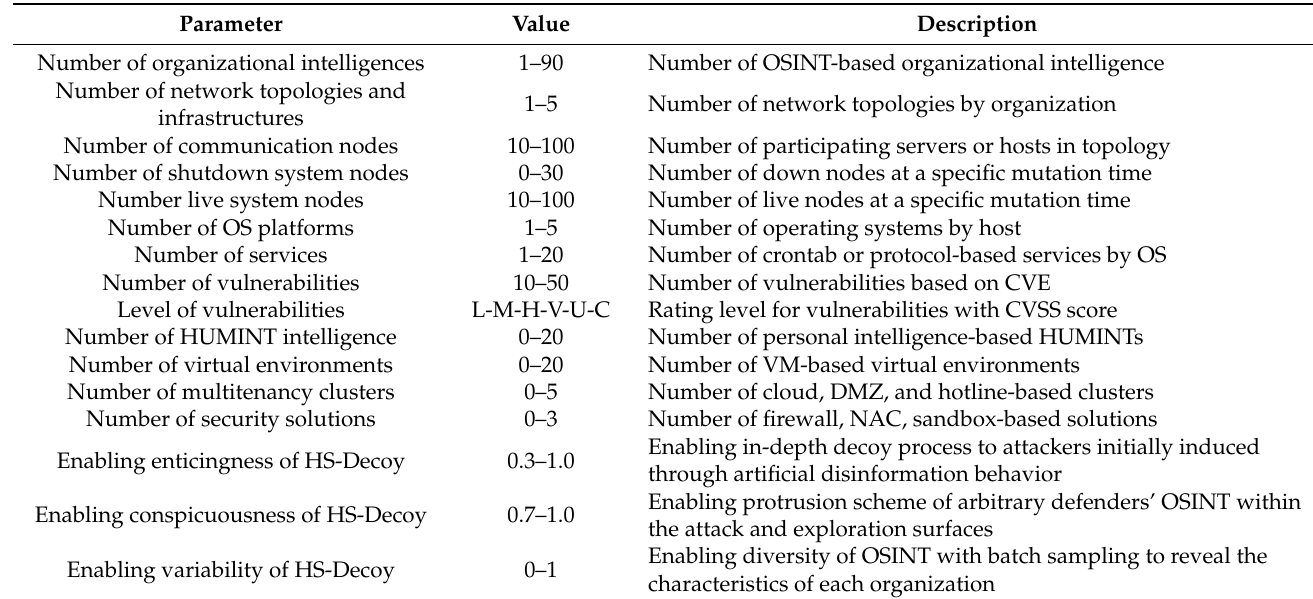
Table A3. Examples of deceptive parameters of OSINT-based